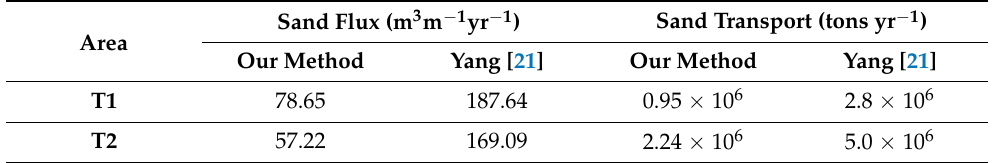
Table 2. The sand fluxes in the main